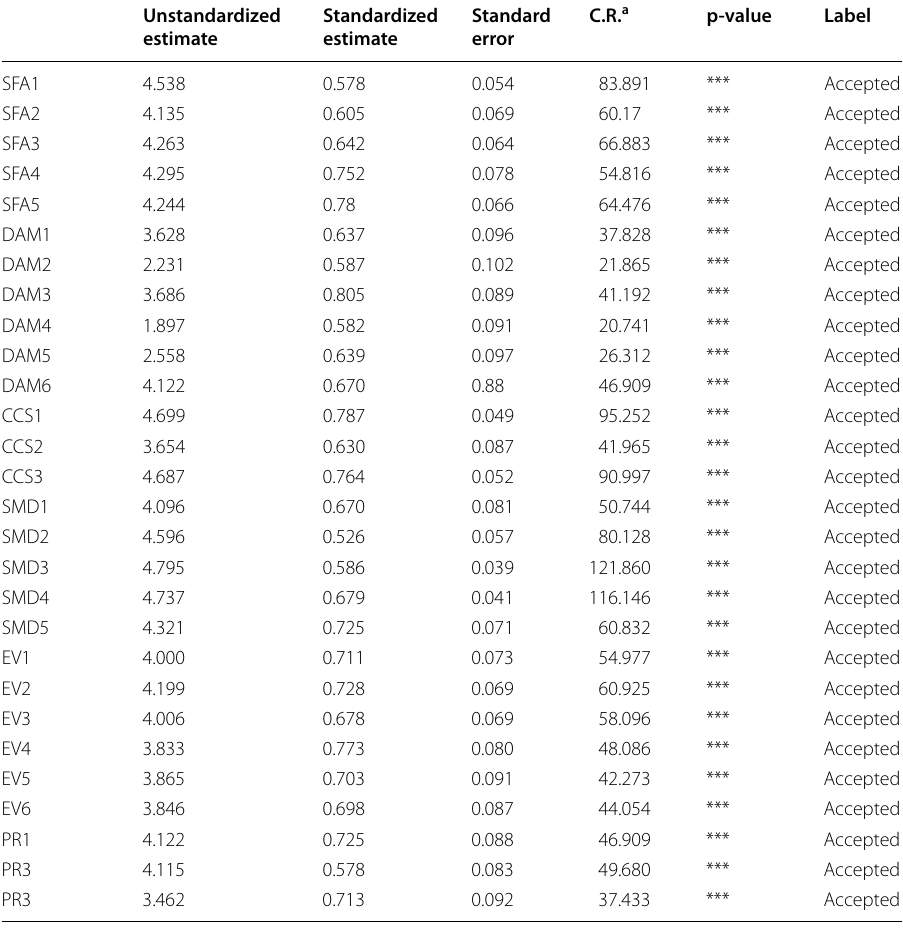
*** Means p-value is significant in AMOS output a Critical ratio (C.R.) of constructs is more than 1.96 and standardized estimates are significant (Hair et al.,